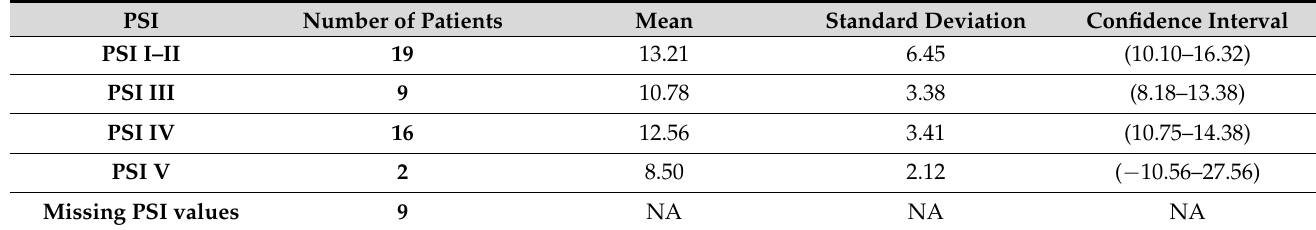
Table 4. Distribution of treatment